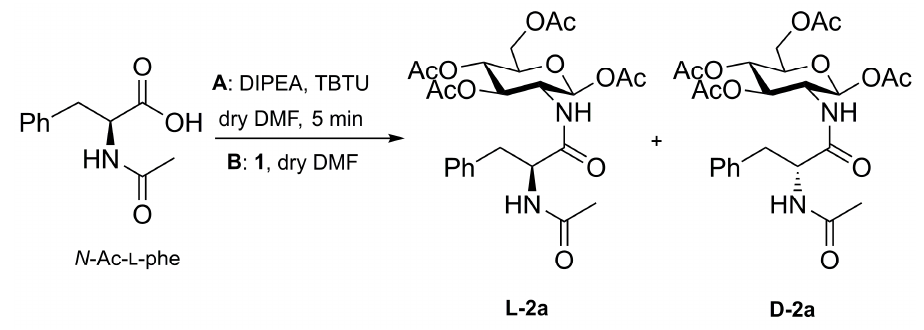
Figure 3. Synthesis of diastereoisomers L-2a and D-2a starting from enantiopure N -acetyl- L -phenyl- alanine. A : activation step; B : amidation with 1 . Table 1. Experimental parameters for the coupling of 1 with N -Ac- L / D -phe mediated by TBTU/DI- PEA. T R = reaction temperature, t R = reaction time, R D = diastereoisomeric ratio ( L-2a : D-2a ). Yield is referred to the sum of the diastereoisomer 1 .